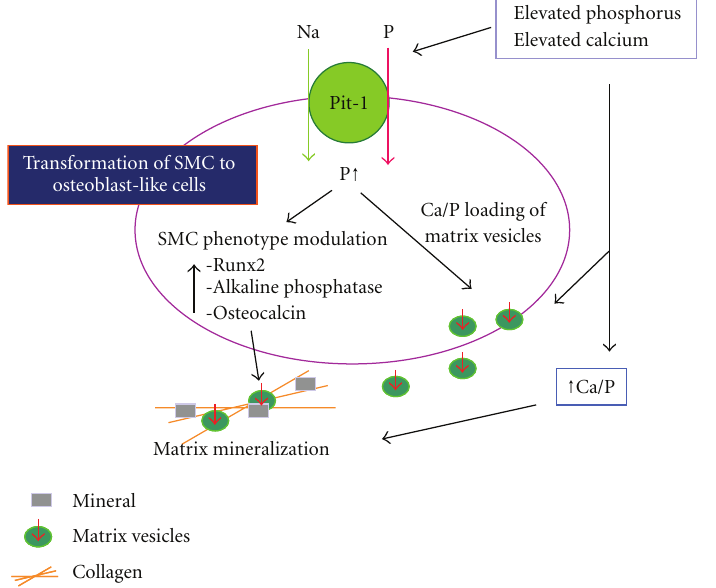
Figure 2: Proposed model for the e ff ects of elevated Ca and P on vascular smooth muscle cell (SMC) matrix mineralization. Cited from the J Am Soc Nephrol 2004; 15: 2959–164 by Giachelli